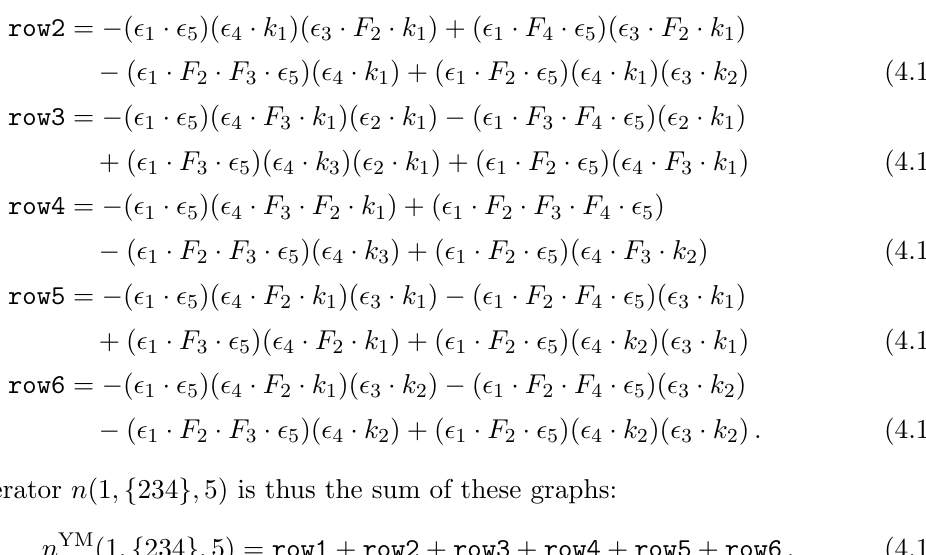
Figure 1 . The spanning trees corresponding to n YM (1 , { 23 } , 4) and n YM (1 , { 32 } , 4). The evaluation is performed under the reference order ρρρ = { 32 }